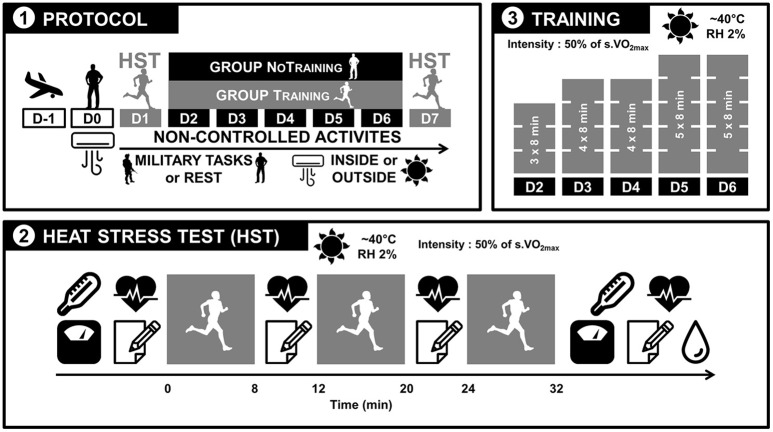
Protocol description. (1) The day after arrival, participants remained at rest in air-conditioned buildings. On D1 and D7, they performed a heat stress test (HST). Between D2 and D6, they either trained (Training [T] group) or did not (No Training [NT] group). From D1 to D7, all participants performed military tasks, mostly outdoors. These activities were not controlled. (2) The HST test consisted of three 8 min periods of running at 50% of the speed at VO2max with 4 min recovery periods in between. Rectal temperature, nude and dry body mass, heart rate, and thermal discomfort were assessed before and after the HST test. During the recovery periods, heart rate, thermal discomfort, and rates of perceived exertion were measured. At the end of the tests, the sweat of some participants was recovered from sweat collectors for sweat osmolality measurements. (3) Training for the T group consisted of 3, 4, or 5 sets of 8-min periods running at 50% of the speed at VO2max with 4-min recovery periods in between.